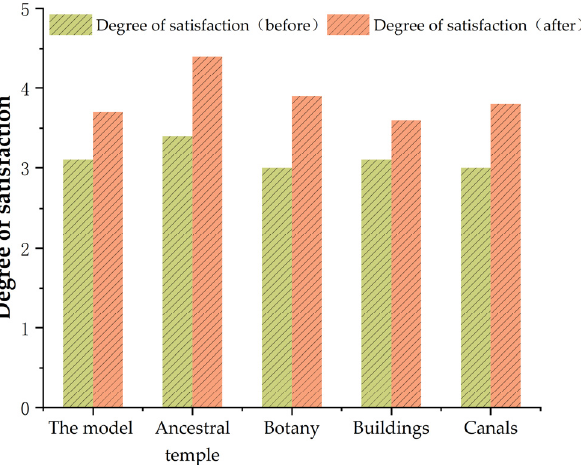
Figure 5. Likert scale satisfaction trend chart. Source: The average of satisfaction was obtained from the statistical data of questionnaire data, and the level of satisfaction was compared before and after the experiment.